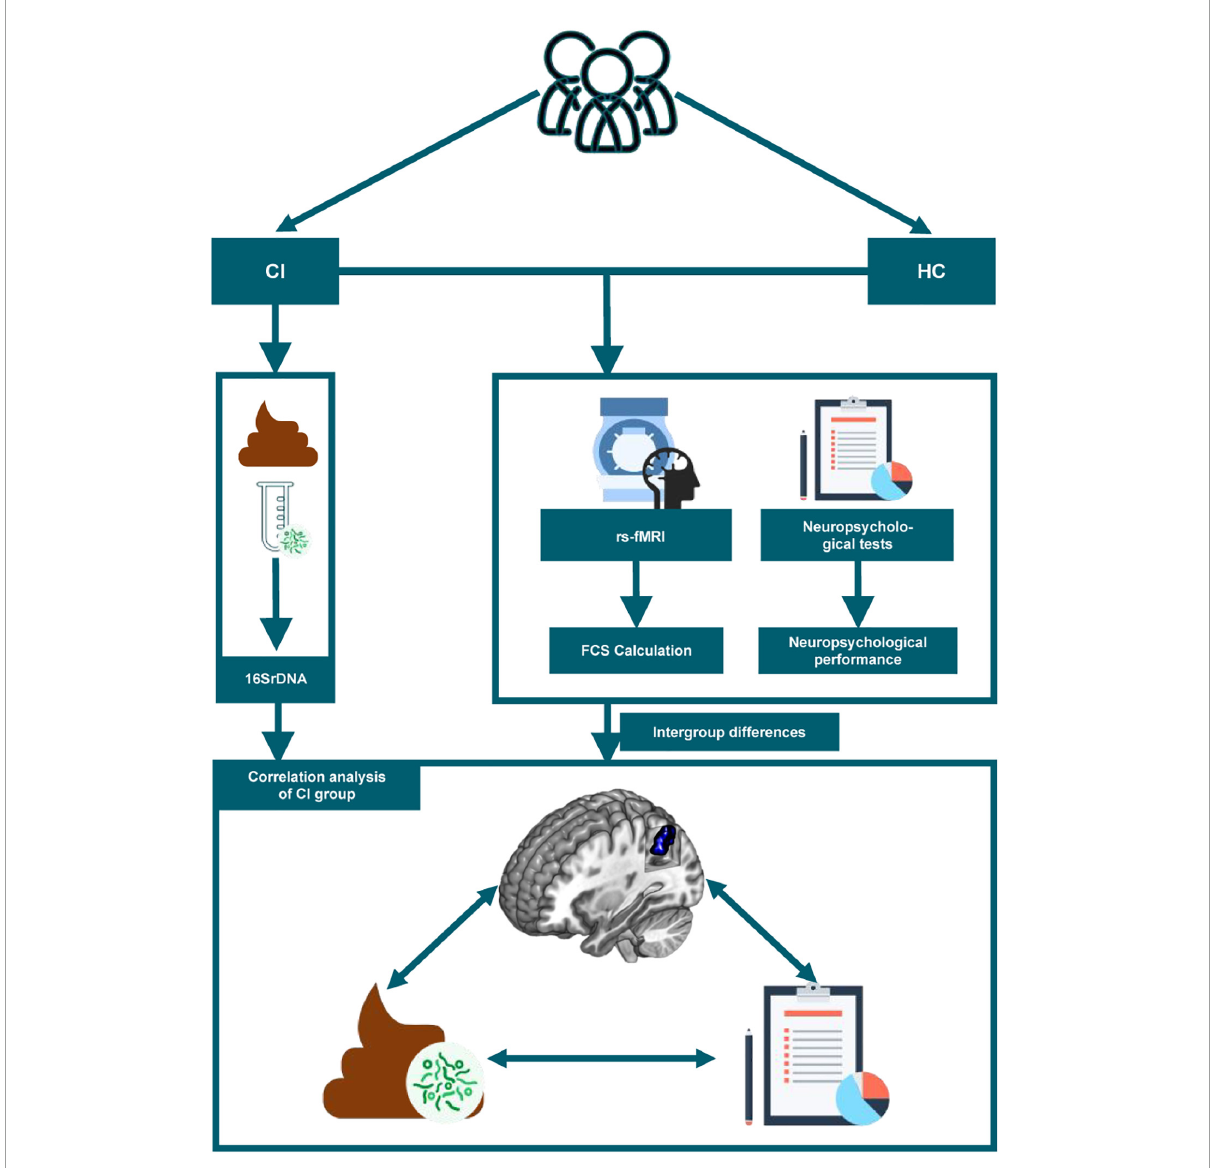
FIGURE1 The study flow chart is depicted. CI, chronic insomnia; HC, healthy controls; rs-fMRI, resting-state functional magnetic resonance imaging; FCS, functional connectivity strength.